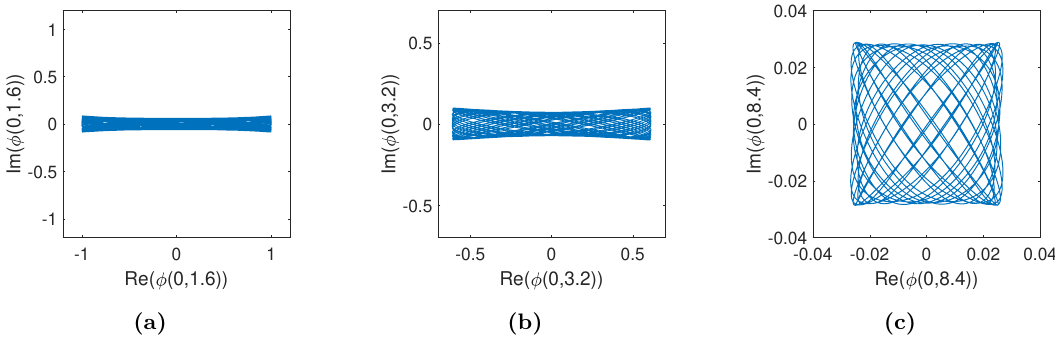
Figure 13. Phase portraits on three points on the y axis in the CSQ stage. The time duration of these data is about 4 charge-swapping periods, i.e., about 23 T